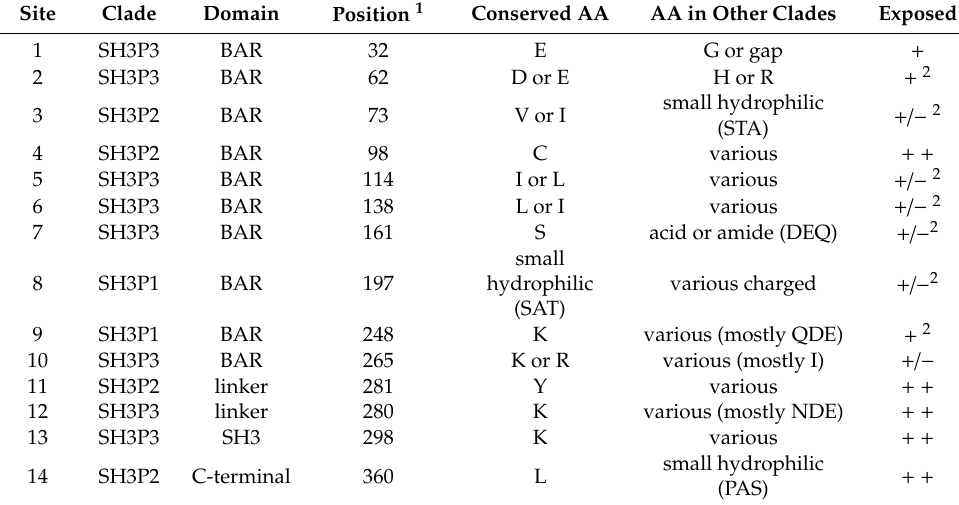
Table 2. Putative clade-specific conserved sites in angiosperm SH3P protein sequences. For site numbering, see Figure 4, and for source alignment see Supplementary Figure S2. In case of multiple options for a given site, amino acids are ordered by frequency of occurrence. The predicted extent of surface exposure was estimated visually based on theoretical structure models (see Figure 5 and Supplementary Data S1) and expressed in semi-quantitative categories ( +/ − semi-buried, + partial surface exposure, + + most of sidechain exposed at a prominent part of the molecule